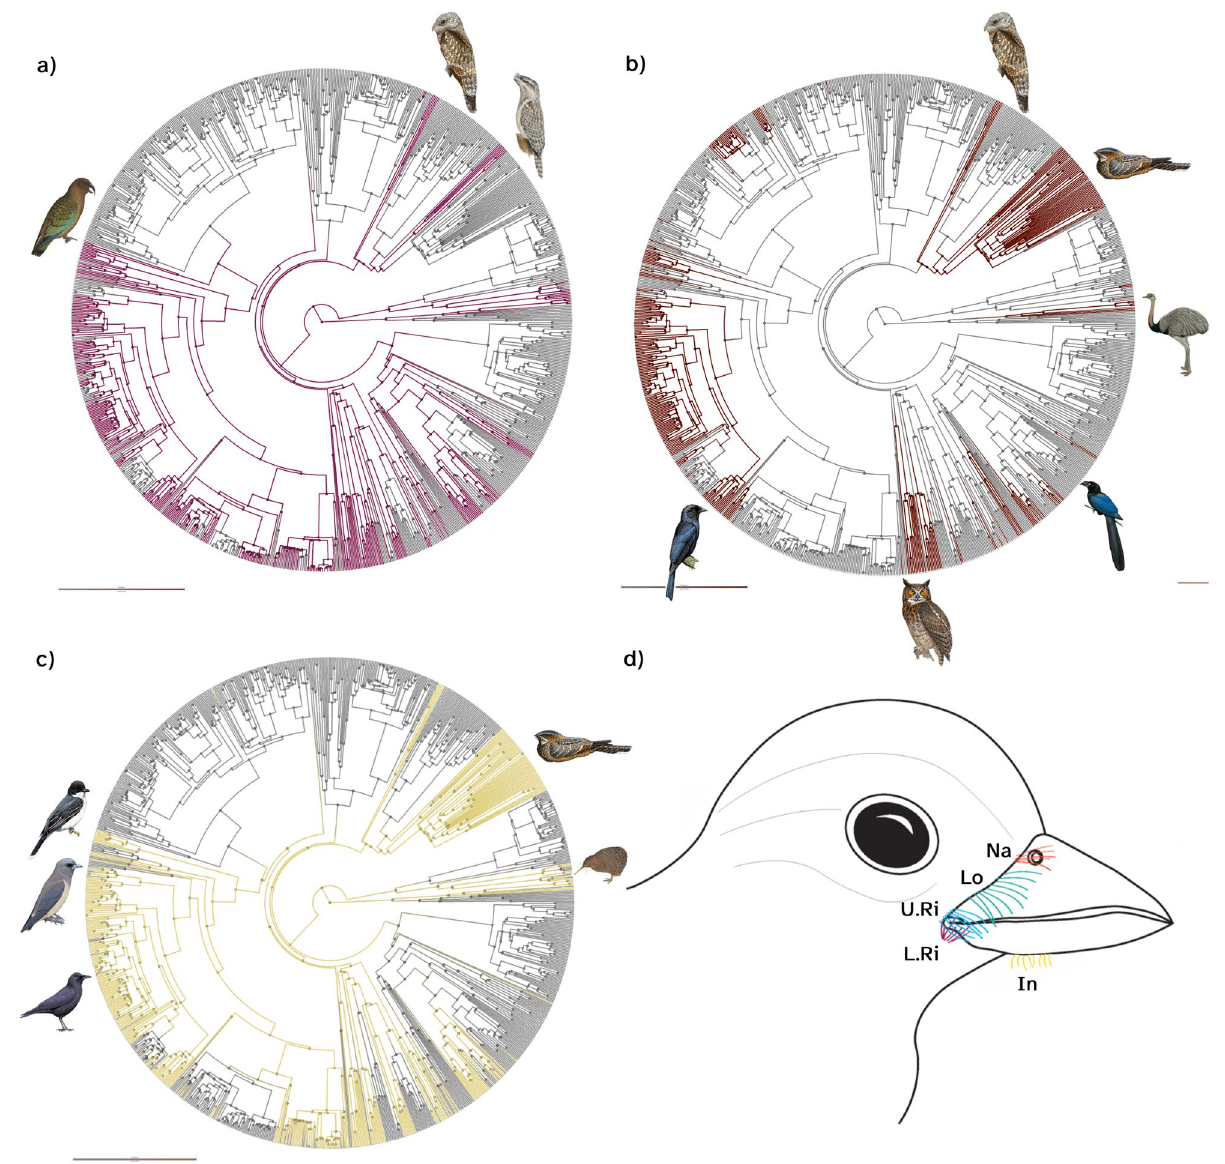
Figure 2. Phylogenetic trees mapping the ancestral character estimation for the presence of facial bristles at different locations: ( a ) lower rictal, ( b ) narial, ( c ) interramal bristles; ( d ) schematic drawing of a bird head illustrating the position of the different types of facial bristles around the beak (Na: narial, Lo: lorial, U.Ri: upper rictal, L.Ri: lower rictal, In: interramal bristles). Terminal branches of the phylogeny correspond with the different species measured. The colour of the branches in the tree gives the posterior probability of the facial bristle character through avian evolution; grey indicates the high probability of the different facial bristles being absent while other colours indicate the presence of these facial